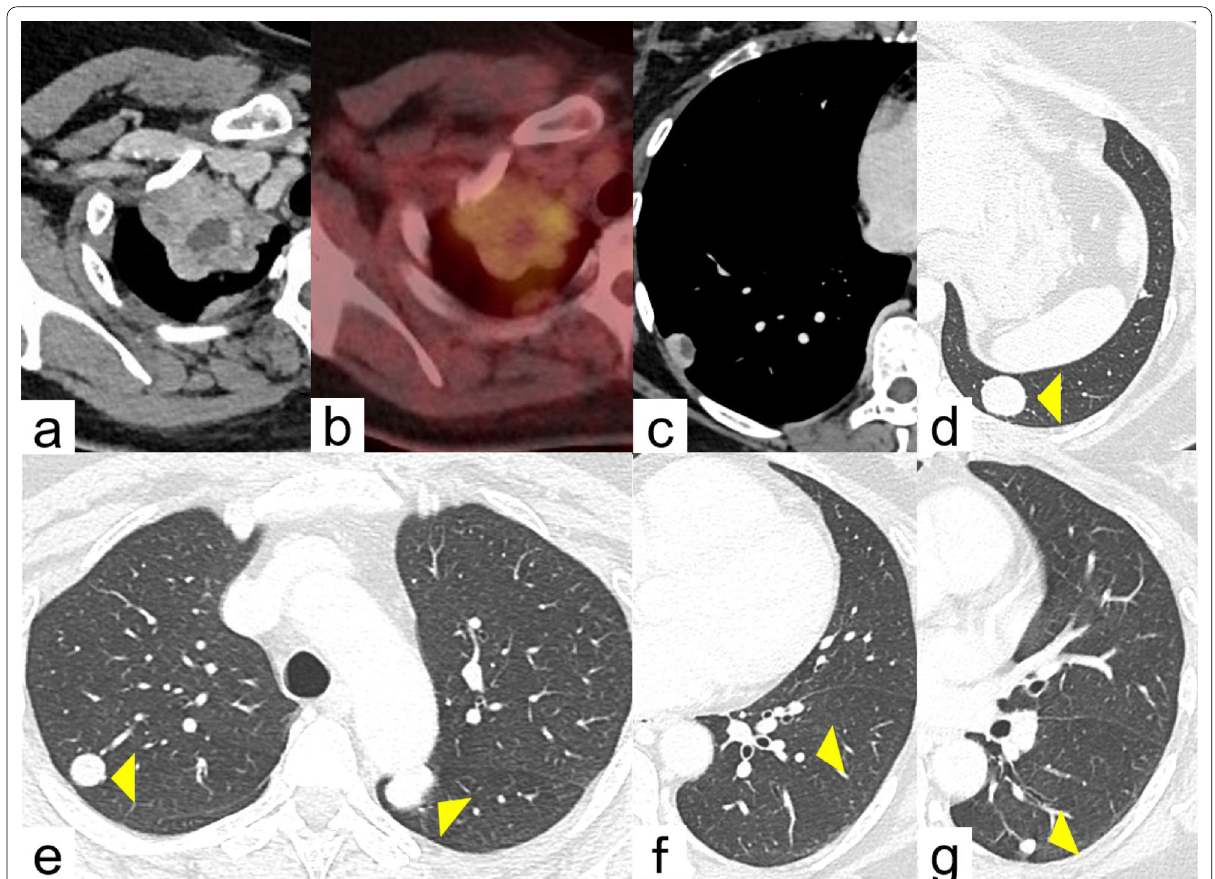
Fig. 1 Computed tomography and positron emission tomography findings before the left lung biopsy. a The right upper lobe lesion contained a cystic fluid component. b Positron emission tomography revealed moderate avidity (maximum standardized uptake value, 4.93) in the right upper lobe lesion. c The tumor in the right lateral basal segment contained a cystic fluid component. d – g Solid tumors were located in the bilateral lungs (yellow